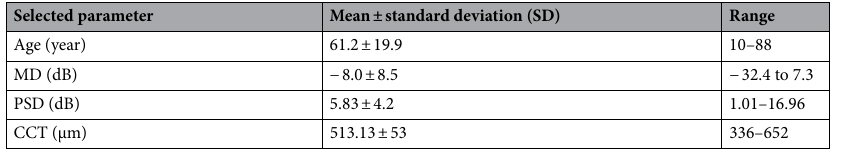
Table 1. Study characteristics. MD mean deviation, PSD pattern standard deviation, CCT central corneal thickness, Values are presented as mean ± standard deviation.